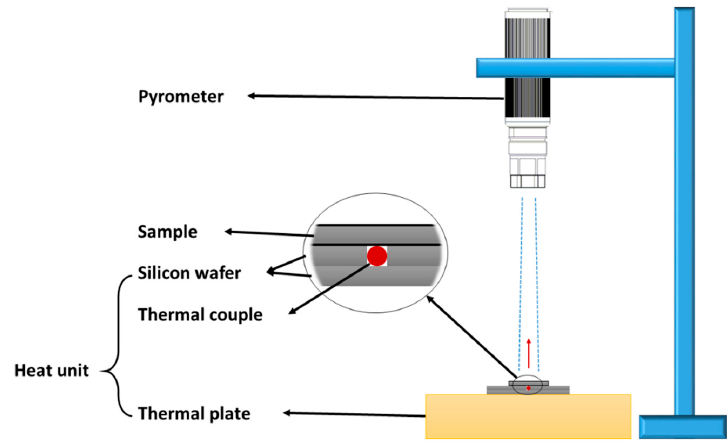
Figure A1. Schematic illustration of the temperature calibration system.